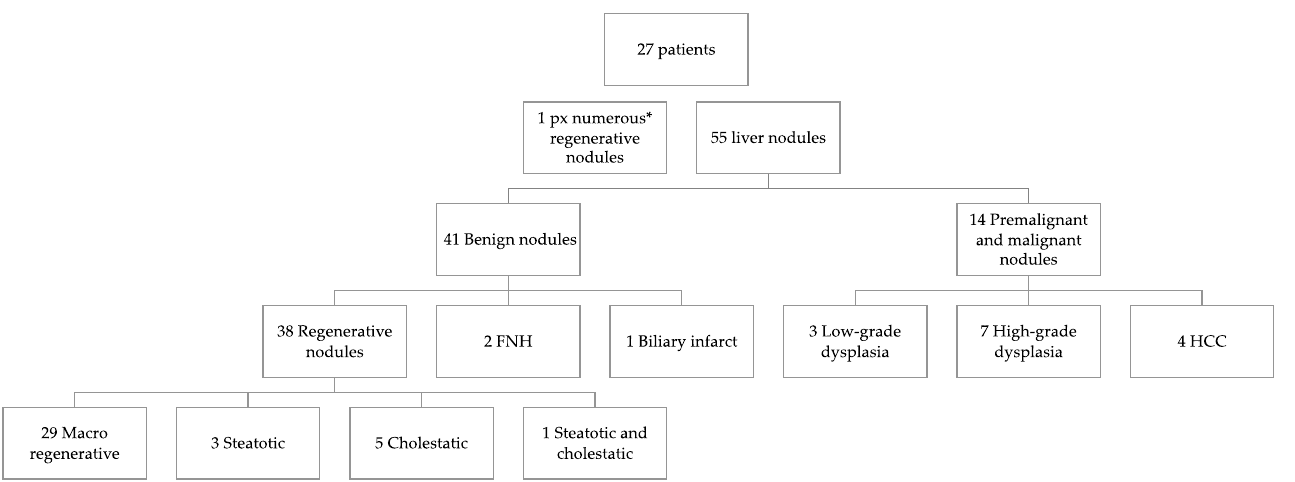
Figure 2. Nodule types on liver explants of biliary atresia patients (FNH, focal nodular hyperplasia; HCC, hepatocellular carcinoma; px, patient; *